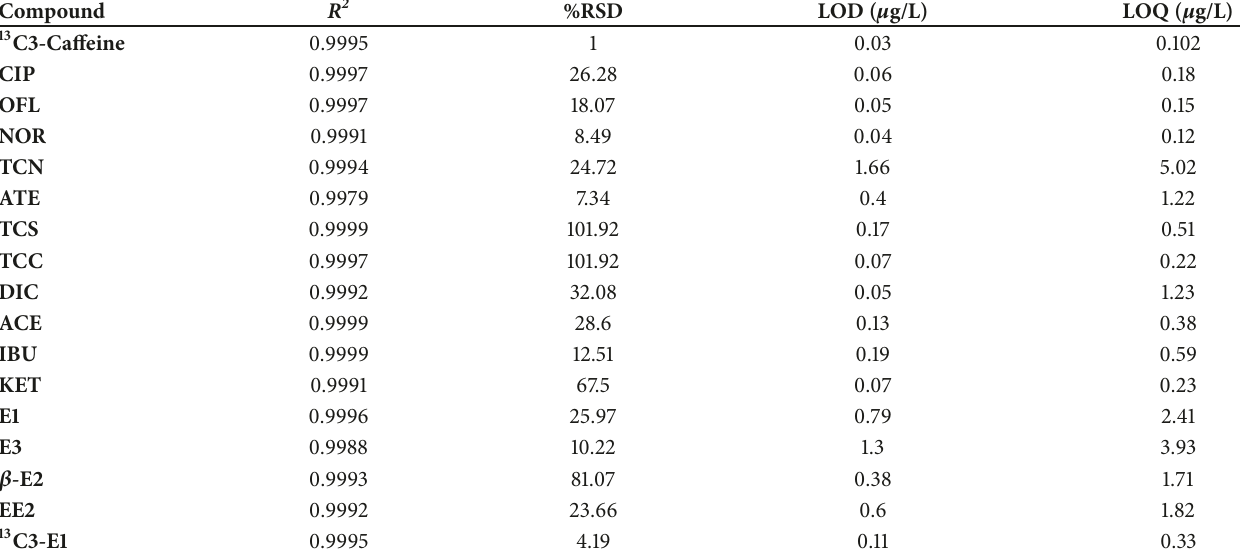
Table 4: Method validation parameters.